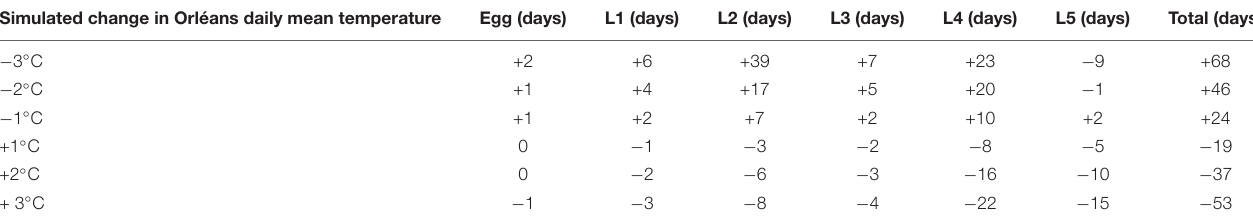
TABLE 2 | Predicted variation of the mean duration of each stage in Orléans depending on simulated changes of daily mean temperature. Simulated change in Orléans daily mean temperature Egg (days) L1 (days) L2 (days) L3 (days)